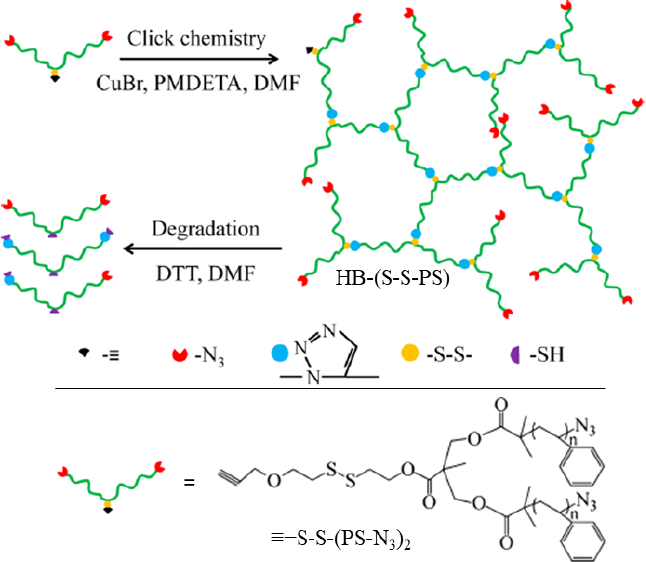
Figure 26. Structure and reaction of the seesaw-like macroinitiator ( ≡− S-S-(PS-N 3 ) 2 ) used to form HB-(S-S-PS), and by-products of the DTT-induced degradation of HB-(S-S-PS). Adapted with permission from [122]. Copyright (2014) American Chemical Society.